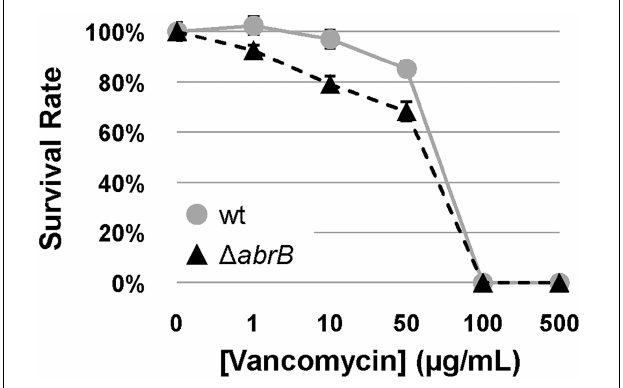
FIGURE 4 | Vancomycin survival assay. Survival assay of spores from S. coelicolor M145 wt (wt; gray circles) and mutant (cid:49) abrB strains (black triangles) against different concentrations of vancomycin in NMMP plates. Error bars show the standard deviation of quadruplicate